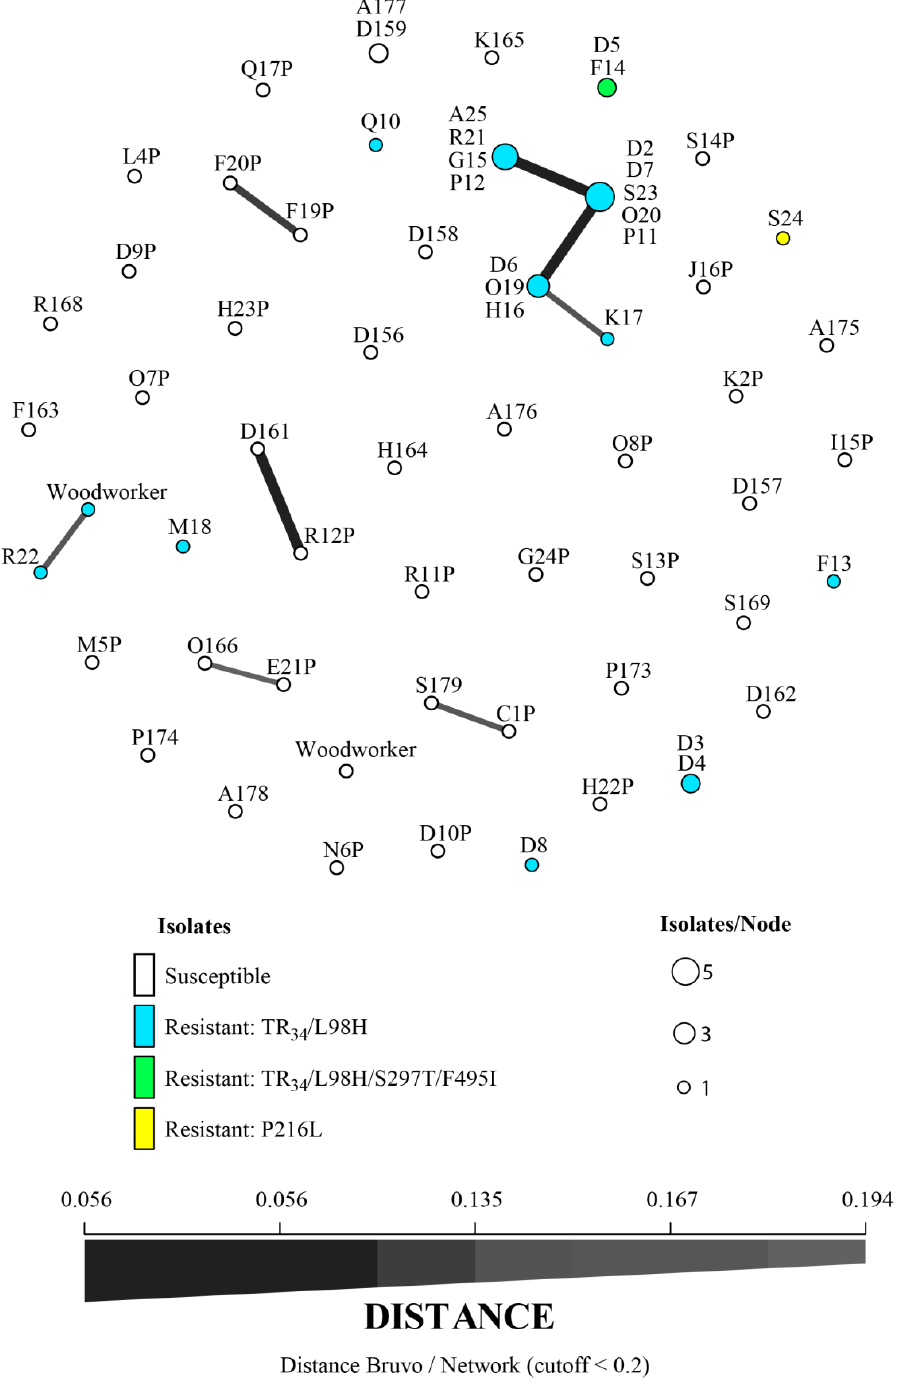
Figure 1. Minimum spanning network of nine microsatellite loci STR Af using Bruvo’s distance. Letters correspond to sawmill and the following numbers ± letters are genotype numbers. Each circle represents one multilocus genotype, the size of which is proportional to frequency. Different colors represent the different isolates (susceptible or resistant, and their mutations on the Cyp51A gene and its promoter ) . Link thickness is proportional to genotype similarity.